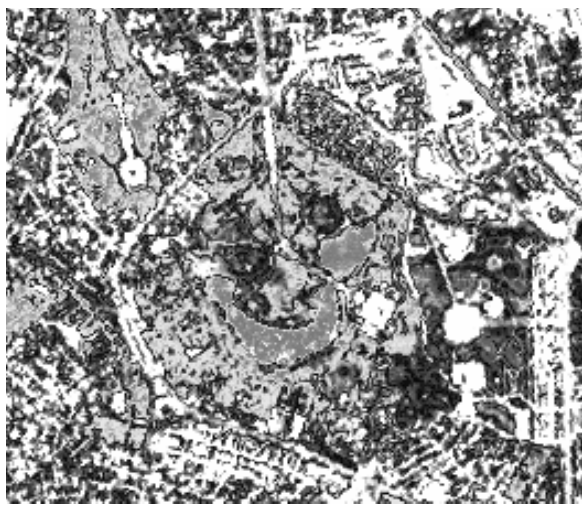
Figure 7. SPOT HRV panchromatic image of study area A bilinear interpolation was used for resampling, which does not introduce geometric artefacts. The differences between GCP